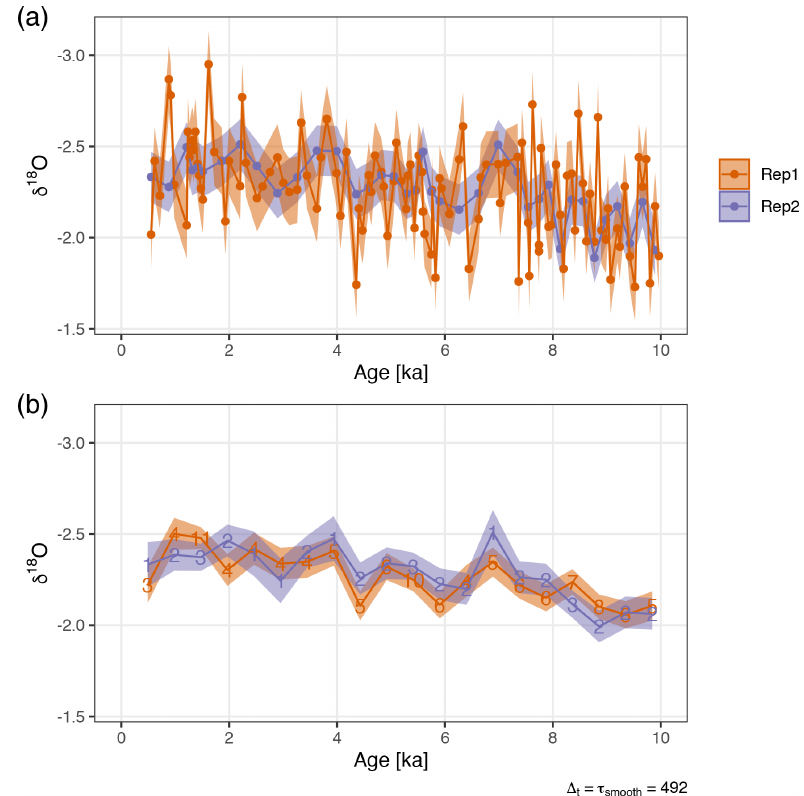
Figure 8. The δ 18 O records from GeoB 10054-4 (a) at their original temporal resolutions and (b) interpolated to a regular time series and smoothed to 492-year resolution. Shaded regions show 1 σ error estimated using the PSEM. The error due to smoothing by bioturbation is excluded as it is deterministic and thus the same for each record. Numbers indicate the number of original data points contained in each averaged proxy